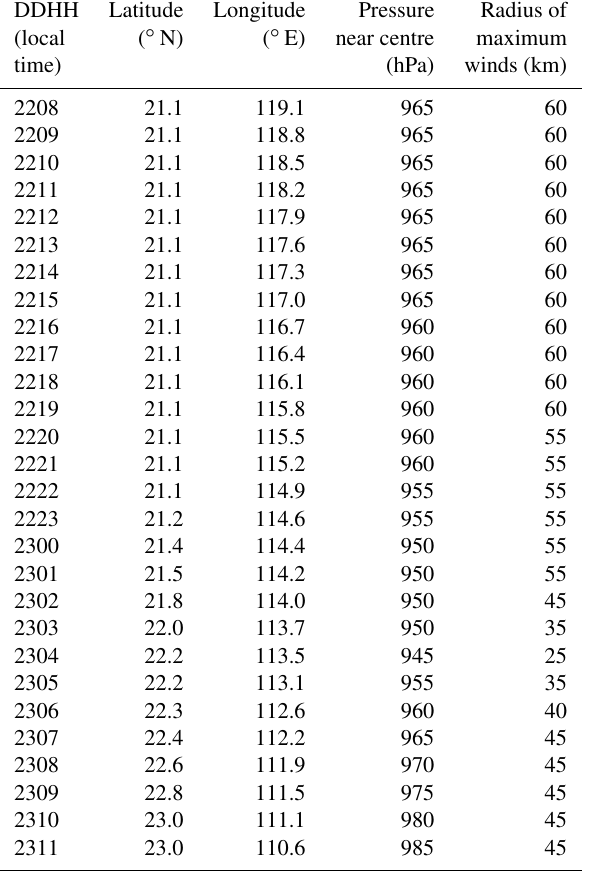
Table 4. The 13 points of the 6-hourly positions, minimum mean sea level pressures near the centre, and the radii of maximum winds of the reconstructed possible track of Typhoon 1874 used for run- ning SLOSH.